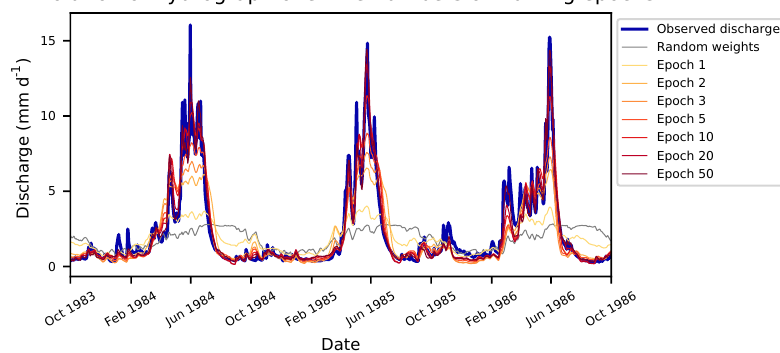
Figure 4. Improvement of the runoff simulation during the learning process of the LSTM. Visualized are the observed discharge and LSTM output after various epochs for the basin 13337000 of the CAMELs data set from 1 October 1983 until 30 September 1986. Random weights represent randomly initialized weights of a LSTM before the first iteration step in the training